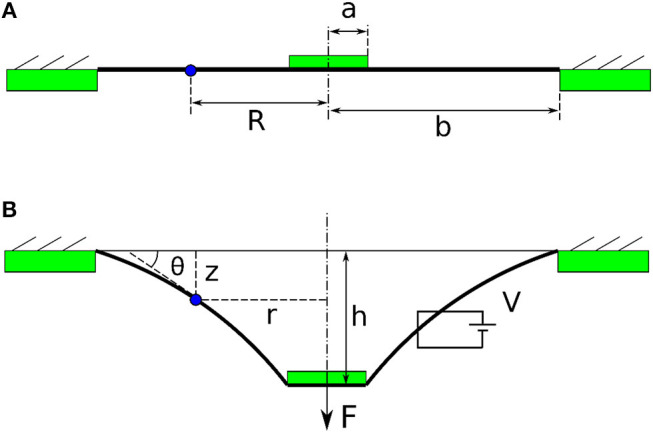
The conceptual illustrations of a single cone DEA. (A) Pre-stretched membrane is bonded to a rigid ring and a central disk. (B) DEA membrane deforms out-of-plane with the existence of a force F and a voltage V.